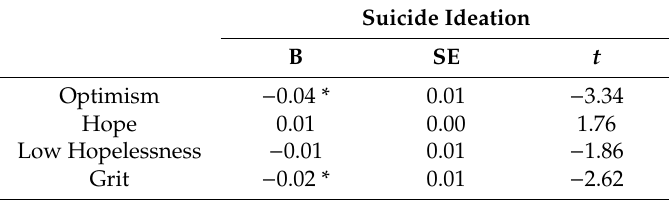
Table 2. Multiple Regression Analyses of all Positive Psychological Variables and Suicide Ideation.